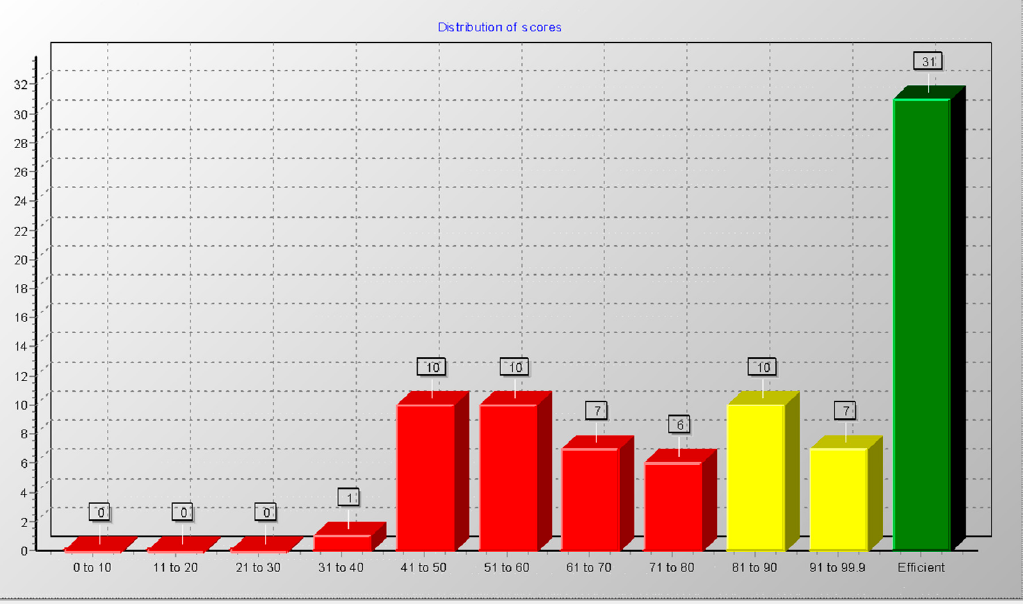
Figure 6. BCC model minimum focused method score distribution.